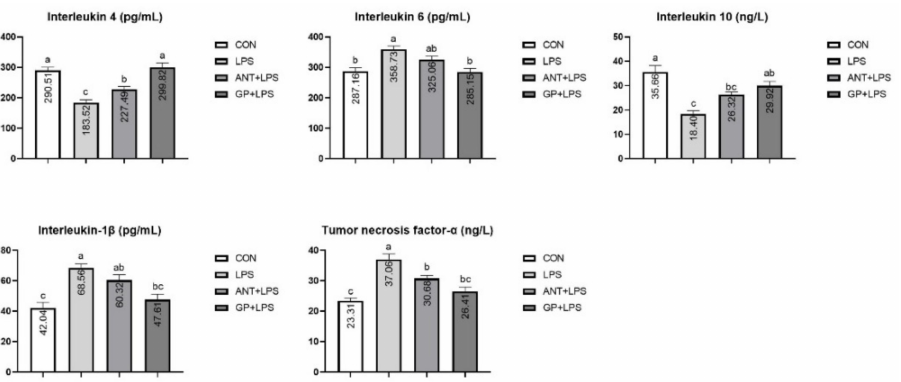
Figure 2. Effects of dietary garlic powder inclusion on serum inflammatory cytokines contents in broilers challenged with lipopolysaccharide (data were presented as mean and SEM, means that do not share the same superscript are significantly different, p < 0.05).